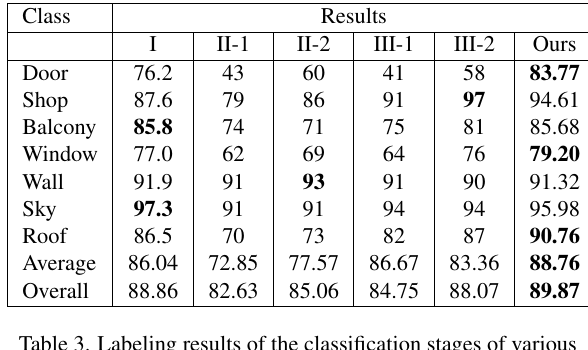
Table 3. Labeling results of the classification stages of various approaches on dataset ECP. Column (I) gives results for the first stage of Auto-context (Jampani et al., 2015). (II-1) and (II-2) present results for the first and the second layer of the three-layered approach (Martinovi´c et al., 2012), respectively. (III-1) and (IV-1) show results for the first and the second layer of ATLAS (Mathias et al., 2016). Best results are marked in